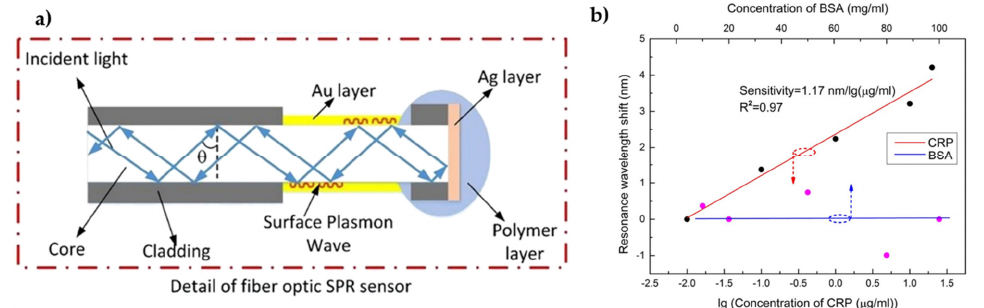
Figure 16. SPR optical fiber for specific detection of CRP: ( a ) representation of the sensing system in a reflected mode: the Au layer was modified with polydopamine as intermediary layer where the anti-CRP antibodies were bonded; ( b ) wavelength shift as response to CRP concentration; a control experiment using BSA is also displayed. Adapted from ref. [30].